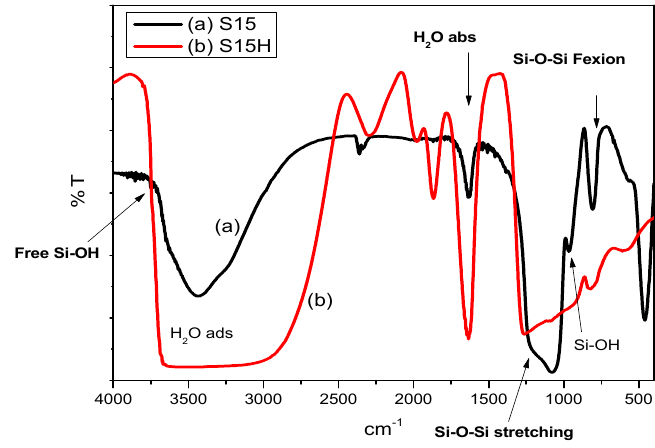
Figure 1. Fourier Transform Infrared (FTIR) spectra of: ( a ) Santa Barbara Amorphous (SBA)-15 precursor silica (S15); and ( b ) SBA-15 sample after being treated with 0.025 M NaOH at a temperature of 313 K (S15H).